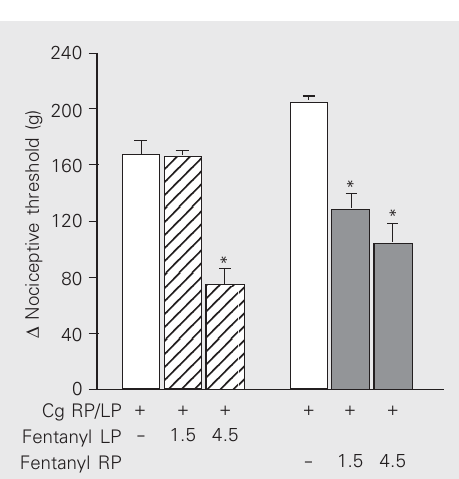
Figure 1. Fentanyl inhibition of the nociceptive threshold of car- rageenan-induced hyperalgesia in rats. Fentanyl (µg) was admin- istered intraplantarly 135 min af- ter the local administration of 100 µl of a carrageenan suspen- sion (250 µg). Each column indi- cates the mean ± SEM (N = 5). *P < 0.01 vs carrageenan + ve- hicle-injected control (ANOVA/ Bonferroni test).